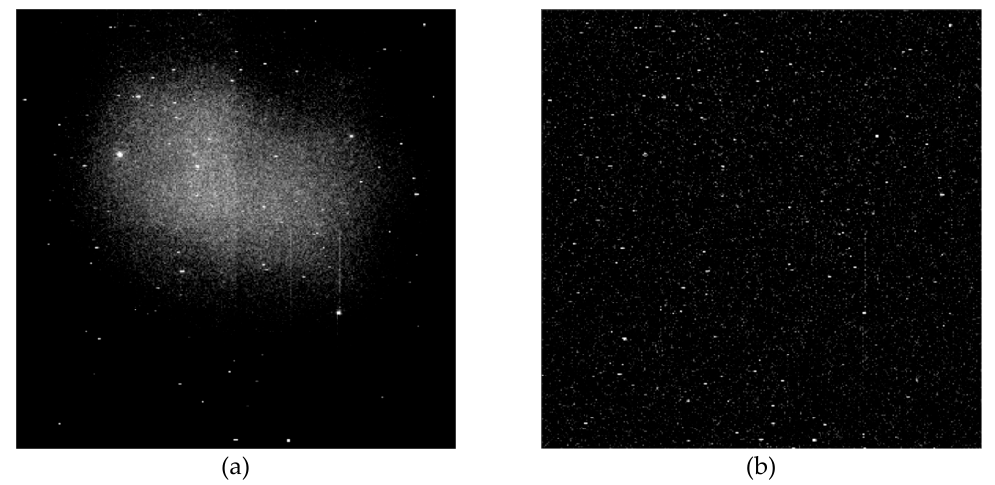
Figure 2. Schematic diagram of structural element decomposition.